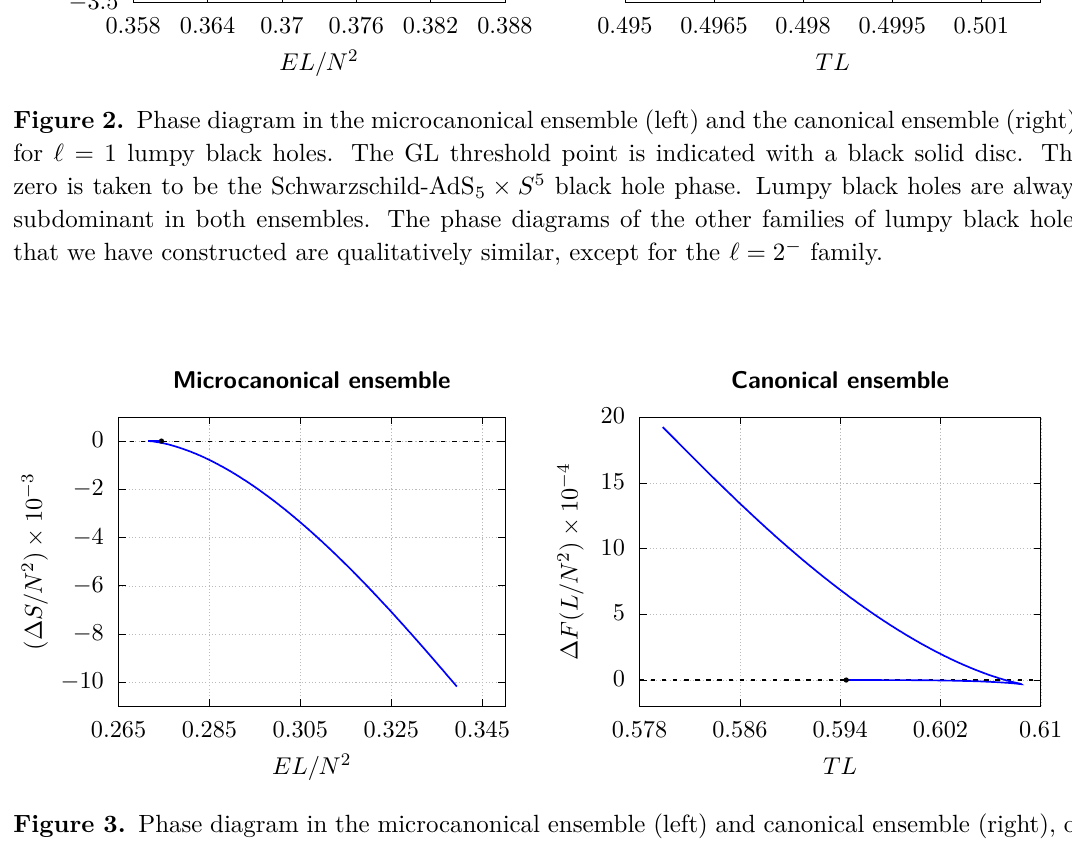
Figure 3. Phase diagram in the microcanonical ensemble (left) and canonical ensemble (right), of ‘ = 2 − lumpy black holes. The GL threshold point is indicated with a black solid disc. The zero is taken to be the Schwarzschild-AdS 5 black hole phase. The ‘ = 2 − lumpy black holes dominate 5 × S the microcanonical ensemble near the GL threshold. In the canonical ensemble, the ‘ = 2 − lumpy black holes are also dominant with respect to the small Schwarzschild-AdS 5 black hole for 5 × S temperatures near the GL point, but thermal AdS 5 is always the preferred phase in this range 5 × S of